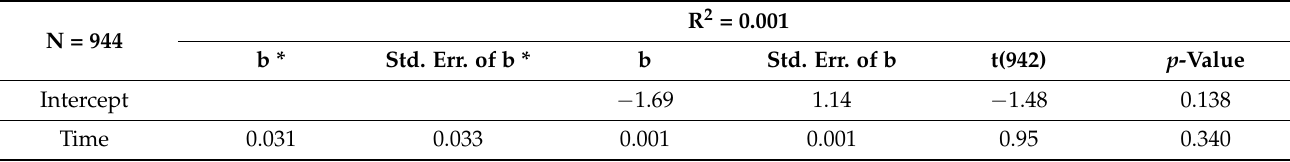
Table 8. Statistical regression analysis for CMI in the Mopani and Vhembe